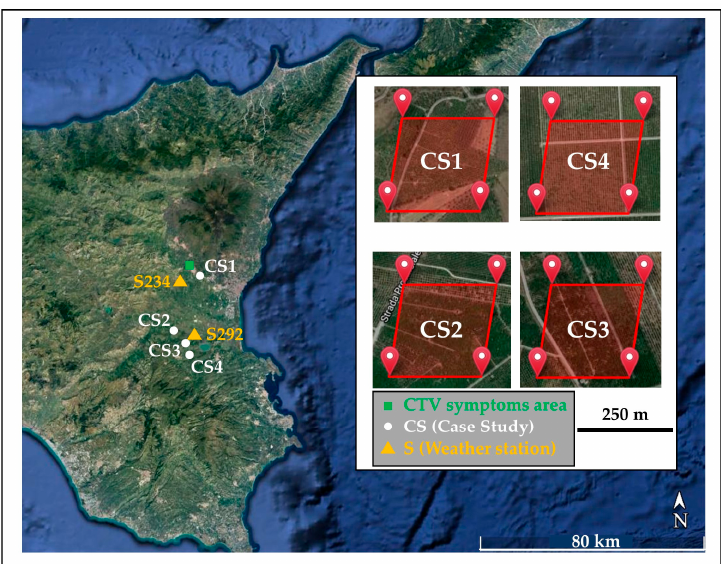
Figure 1. Map of the selected case studies (CS i I = 1, 4 at the Moderate Resolution Imaging Spectroradiometer (MODIS) pixel resolution) in Sicily with the indications of the first Citrus tristeza virus (CTV) focus area and of the meteorological stations.